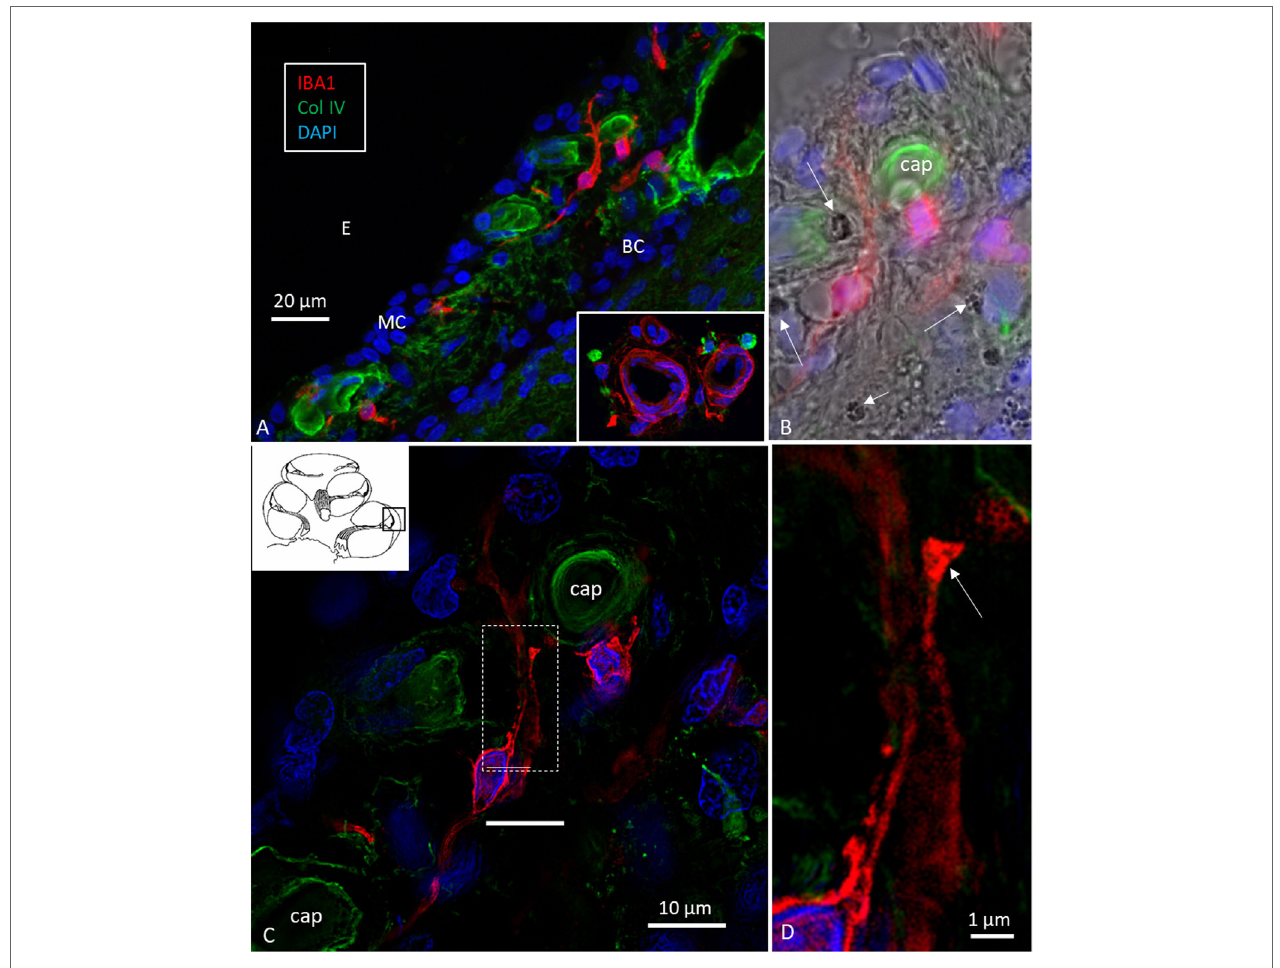
FigUre 3 | Ionized calcium-binding adaptor molecule 1 (IBA1) cells in the stria vascularis are not intermediate cells (ICs). Confocal microscopy (a,b) and SR-SIM [ (c,D) maximal intensity projections] images of IBA1-positive cells in the lateral wall of the human cochlea. Their long pseudopodia reach the wall of the strial capillaries and MCs. A terminal bulb can be seen at the capillary wall [arrow in panel (D) ]. The IBA1 cells contain no melanin granules [arrows in panel (b) ], suggesting they are not ICs. MC, marginal cells; BCs, basal cells; E, endolymph; Cap, capillary of the StV. Inset in panel (a) shows perivascular macrophages (IBA1, green) in the wall of the scala